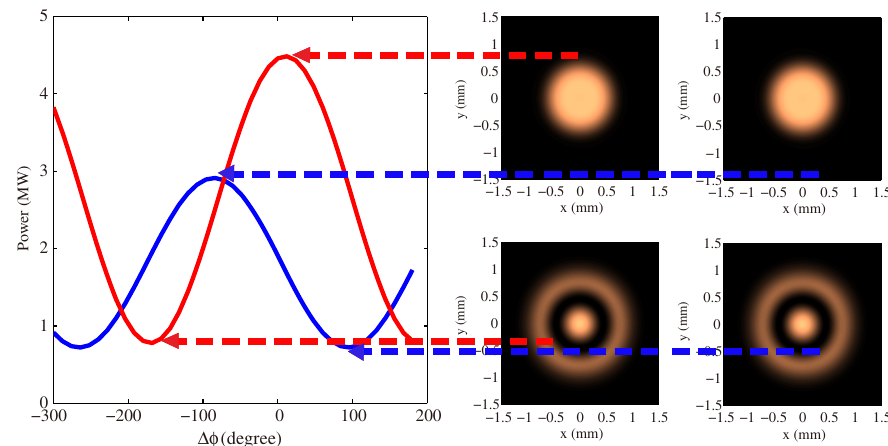
FIG. 6. Coherent photon beam spatial distribution of two successive undulator segments (blue: tuned to a wavelength of 49.49 nm; red: tuned to a wavelength of 49.84 nm; spatial profile from one individual undulator segment can be seen in Fig. 3) for the best phase difference (the right upper two plots) and the worst phase difference (the right lower two